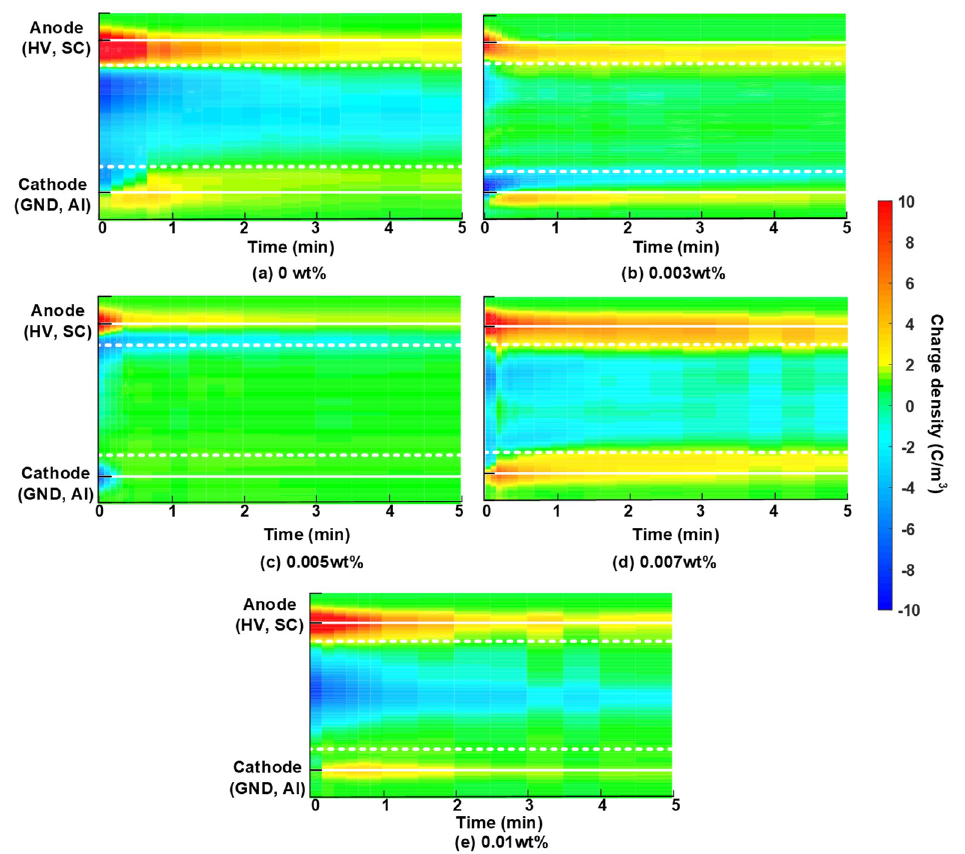
Figure 6. Space charge dissipation in LDPE composites with the different filler content at 60 °C. ( a ) 0 wt %, ( b ) 0.003 wt %, ( c ) 0.005 wt %, ( d ) 0.007 wt % and ( e ) 0.01 wt % graphene/LDPE nanocomposites.